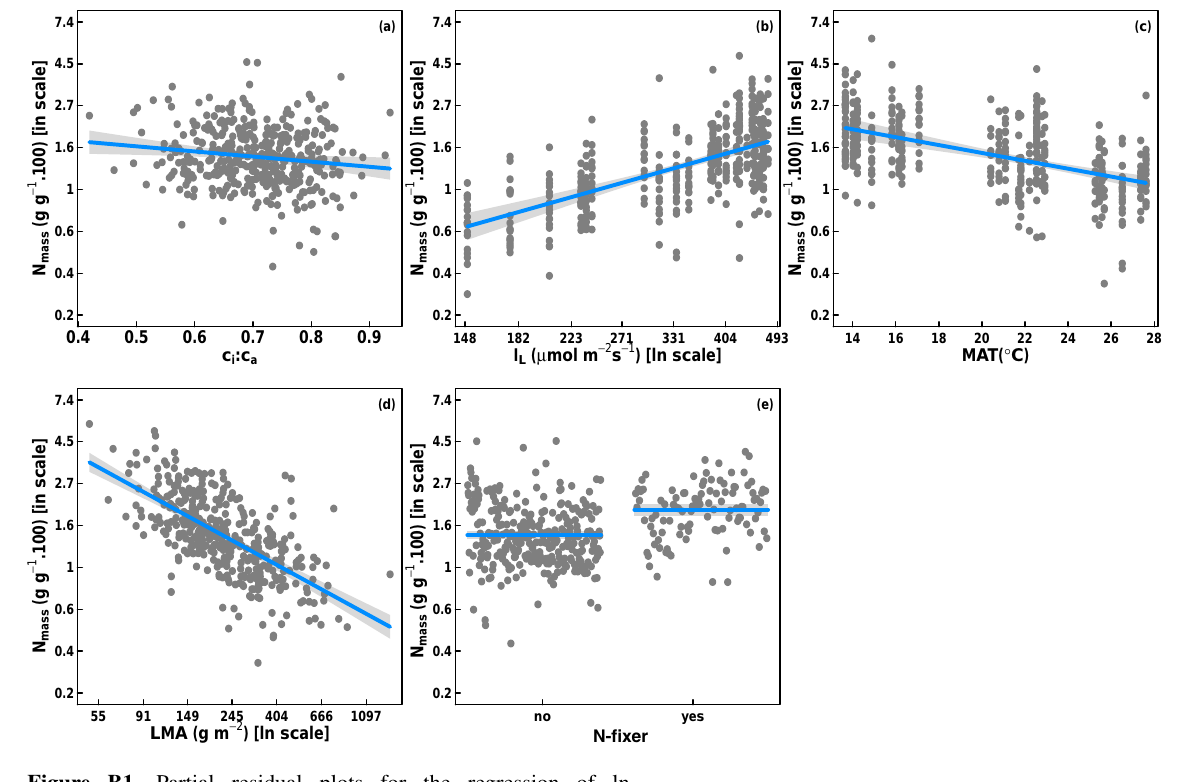
Figure B1. Partial residual plots for the regression of ln (N mass × 100) (gg − 1 ) as a function of c i : c a (from δ 13 C), ln (mean canopy PAR, IL) (µmolm − 2 s − 1 ), MAT ( ◦ C), ln LMA (gm − 2 ), and the factor “N-fixer” at species level.